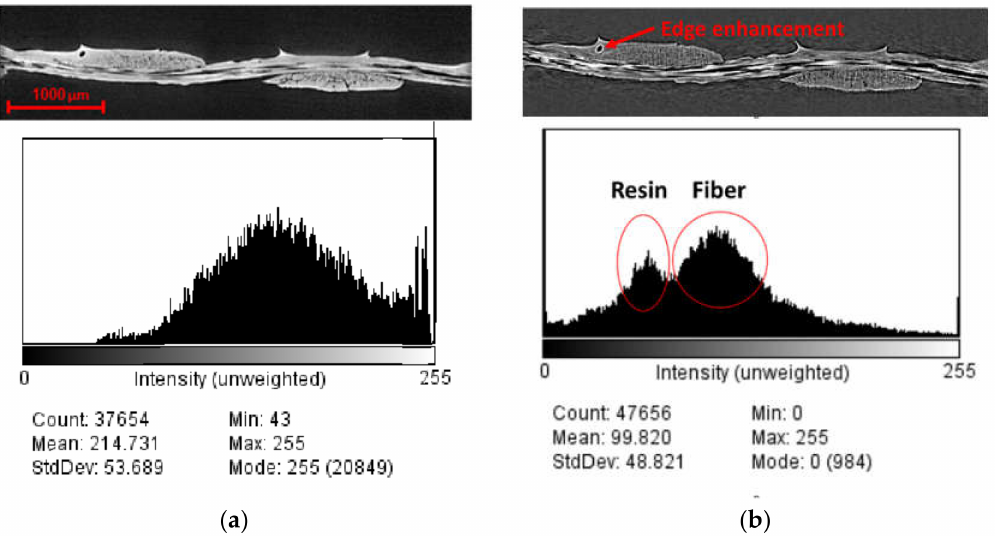
Figure 8. Cross-section of CT-data of a prepreg sample at two di ff erent object-detector distances; ( a ) absorption contrast; ( b ) propagation phase contrast. Voxel size was constant at 2.47 µ m 3 .